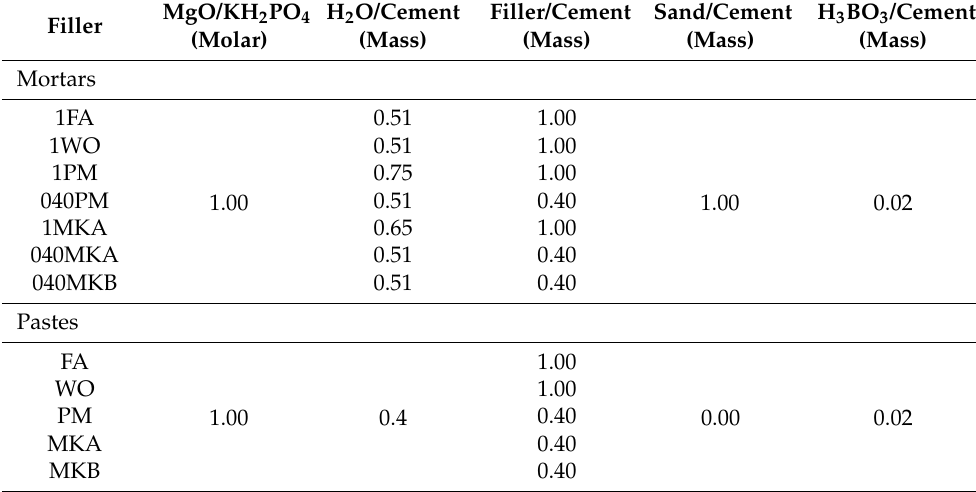
Table 2. Formulations of MKPC pastes and